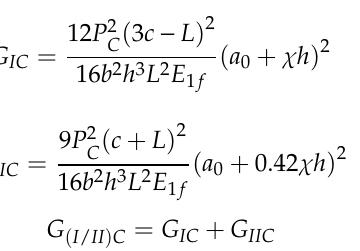
Figure 7. Mixed-Mode Bending (MMB) test specimen for Mixed-mode I/II delamination: ( a ) configuration and dimensions, ( b ) test fixture and final test specimen.